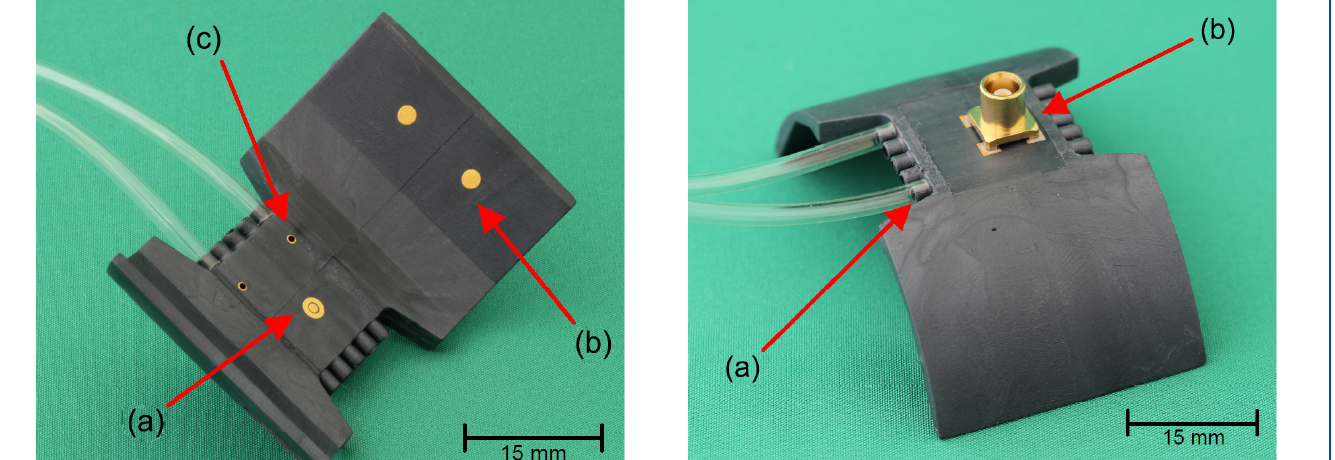
Figure 3. Back side of the 3D-MID carrier with connected fluidic tubes (a) and mounted MCX connector (b)